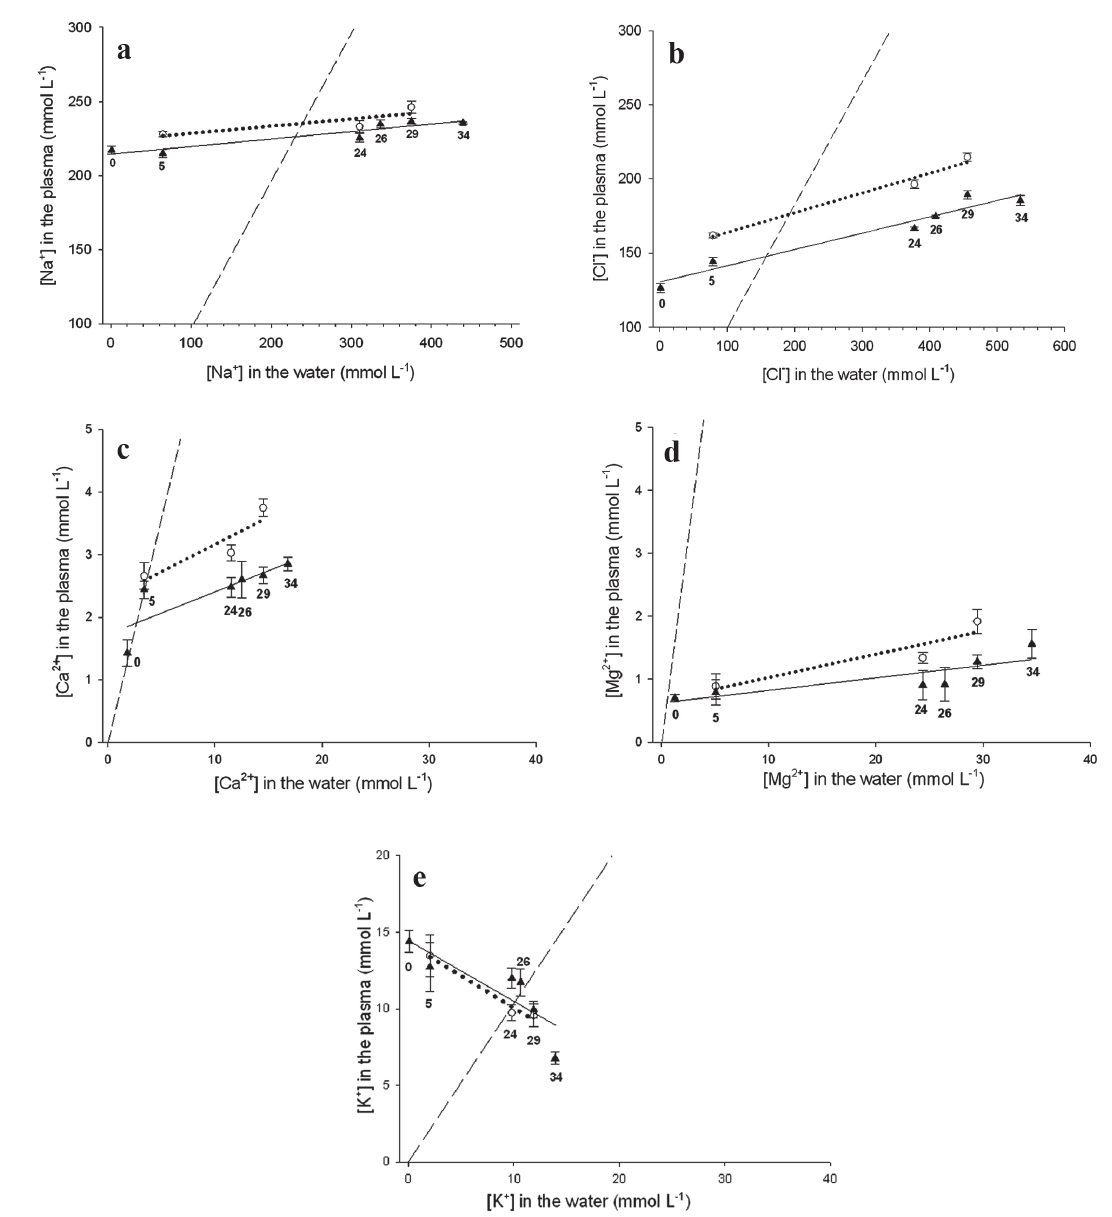
Fig. 1. Ion regulation curves for Na + ( a ), Cl - ( b ), Ca 2+ ( c ), Mg 2+ ( d ), and K + ( e ) in the plasma of M. furnieri (  ) and G. barbus (  ) collected from water at different salinities from the São Gonçalo channel. Data are expressed as the means ± SEM (n = 12) (P < 0.05); the traced line represents the isoionic line. The following equations were fitted to the data: Micropogonias furnieri (Na + : y=214.52+0.051x, r 2 =0.87; Cl - : y=130.45+0.110, r 2 =0.94; K + : y=14.44-0.396x, r 2 =0.71; Ca 2+ : y=1.73+0.067x, r 2 =0.70; Mg 2+ : y=0.62+0.020x, r 2 =0.70); Genidens barbus (Na + : y=223.74+0.048x, r 2 =0.70; Cl - : y=150.56+0.133x, r 2 =0.98; K + : y=14.23-0.419x, r 2 =0.97; Ca 2+ : y=2.29+0.087x, r 2 =0.82; Mg 2+ : y=0.66+0.037x, r 2 =0.85), where x = salinity and y = plasma ion concentration (mmol L -1